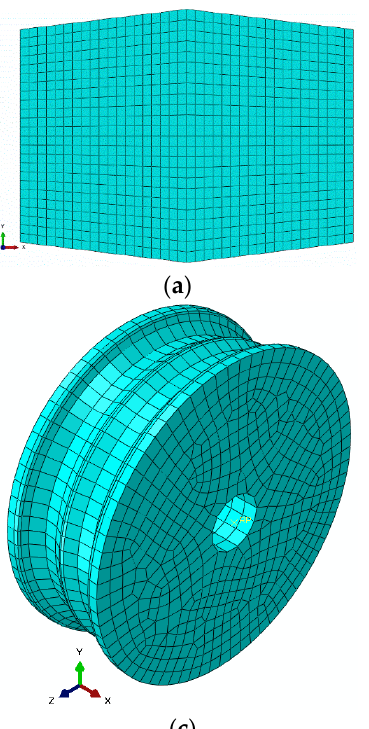
Figure 8. Two billet designs: ( a ) single barrel, ( b ) double barrel (dog bone).